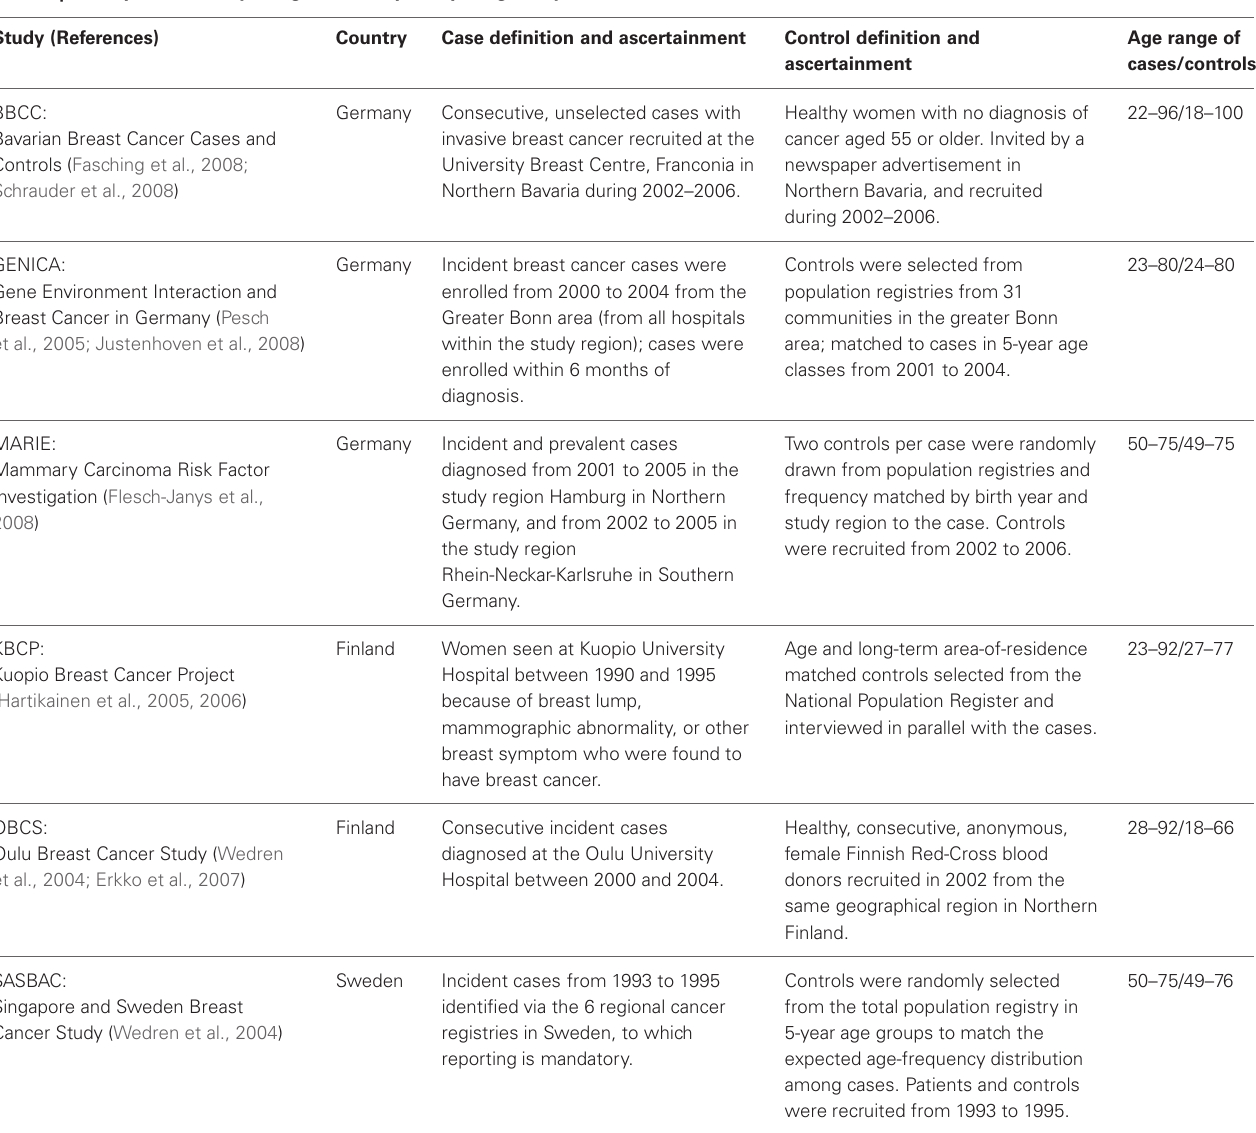
Table 1 | Description of study design for each participating